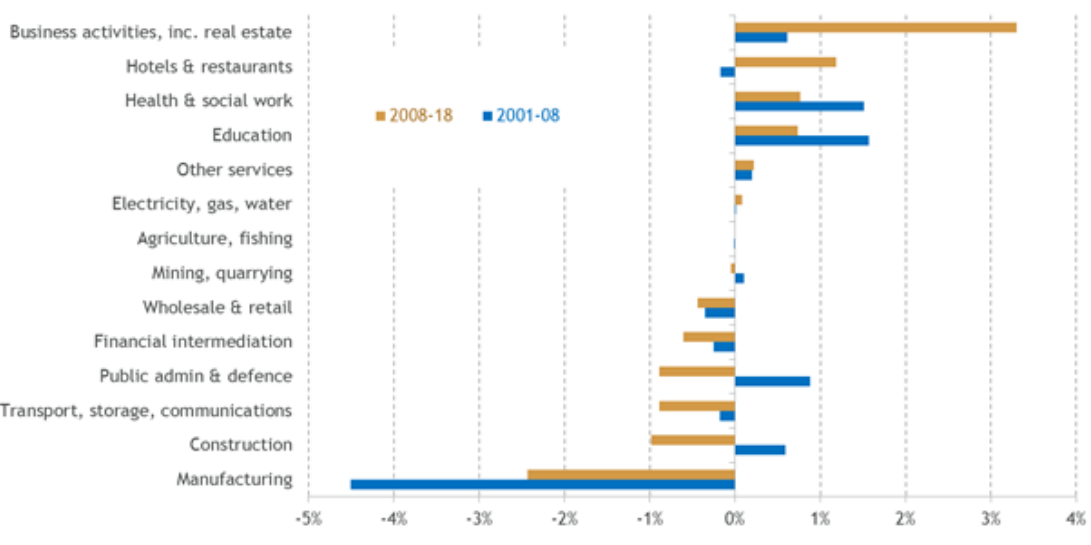
Figure 22: Business, education and health have expanded significantly over the past two decades Weighted percentage change in the share of employment by